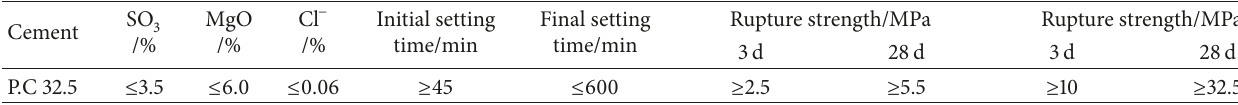
Table 2: The basic parameters of cement.